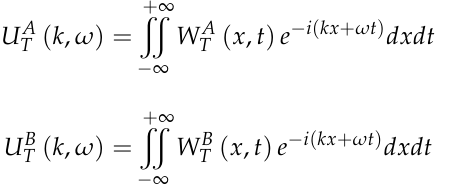
Figure 3. Schematics of Lamb wave generation and measurement: ( a ) W A generated from PZT A and ( b ) W B generated from PZT B. Superscripts A and B represent Lamb wave excited from PZT A and PZT B, respectively.